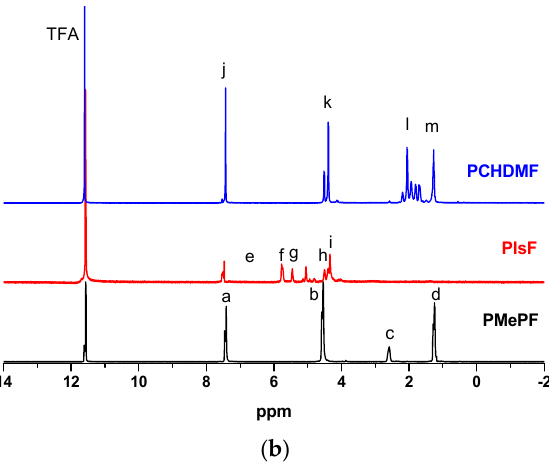
Figure 1. ( a ) Structures; and ( b ) 1 H-NMR spectra of PMePF, PIsF and PCHDMF polyesters.